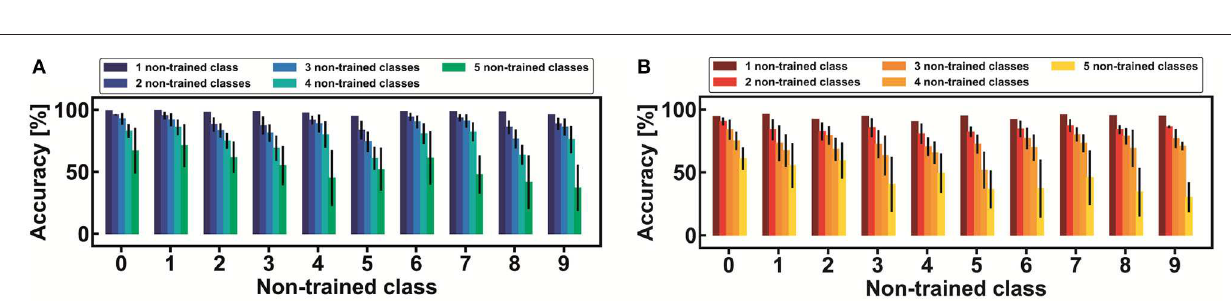
FIGURE 11 | Bar charts of continual learning classification accuracy for each one of the classes of the MNIST (A) and the Fashion-MNIST (B) datasets. Note that, on average, the accuracy of a reference non-trained class varies depending on the number of the further non-trained classes. In particular, as the number of non-trained classes increases, the continual learning accuracy degrades: this is mainly due to the confusion between new classes and to the worse efficiency in achieving good transfer learning from the reduced training sub-dataset. Note that every bar is provided with the 3 σ standard deviation.